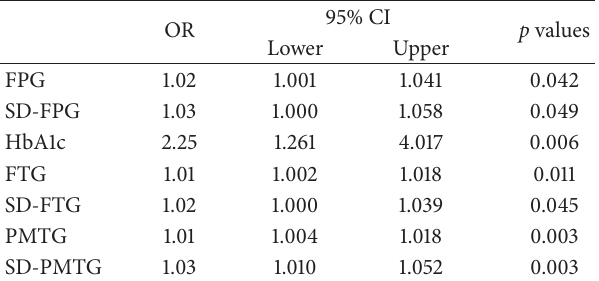
Table 2: Bivariate logistic regression analysis for progression of nephropathy.